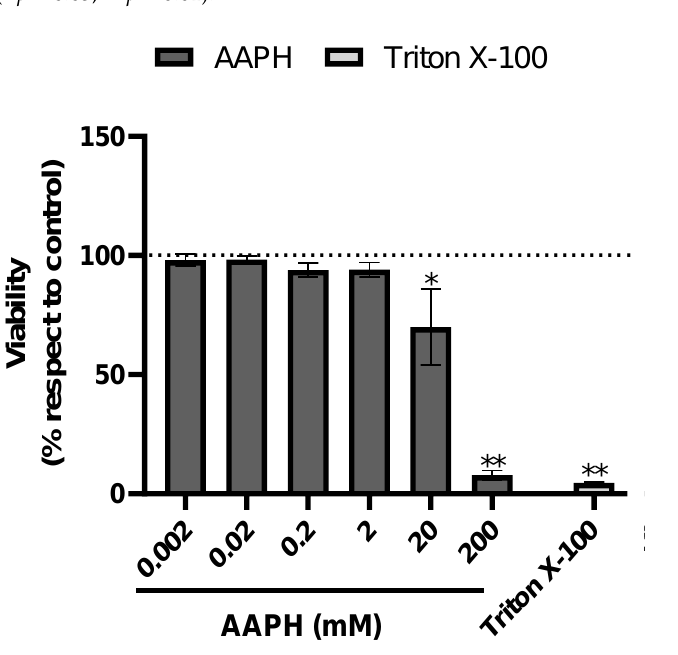
Figure 1. Maximum concentration of phenolic extracts of chickpea. Cell viability evaluated by Alamar blue of HUH-7 cells treated or 24 h with phenolic extracts of chickpeas at different dilutions (1/10, 1/100, 1/1000 and 1/10,000). Positive control of cell death, cells treated with Triton X-100 at 1% for 10 min. Data are expressed as percentage of viability with respect to the control cells. Data are shown as mean ± SD (n = 3). A one-way ANOVA statistical test was performed followed by Tukey test. Statistically significant differences compared to the control group (cells without treatment) (* p < 0.05, ** p < 0.01).